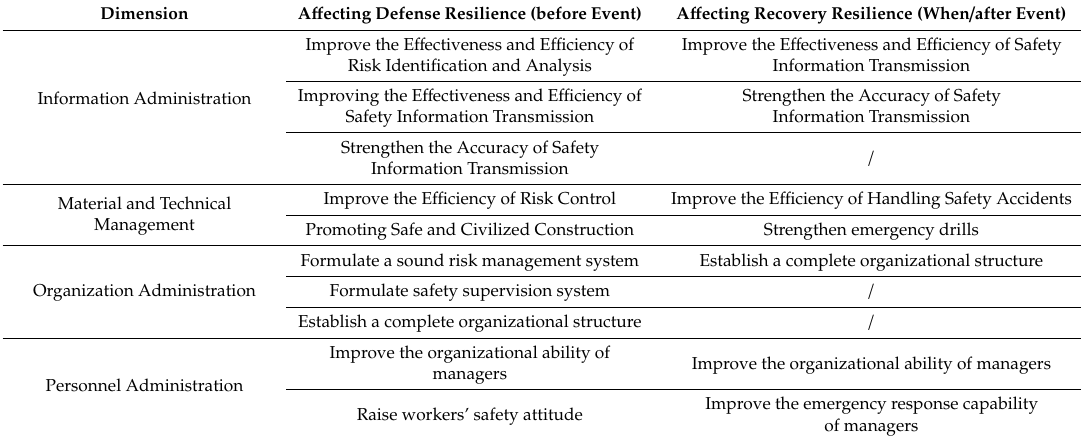
Table 9. Key safety management factors in each stage of accident